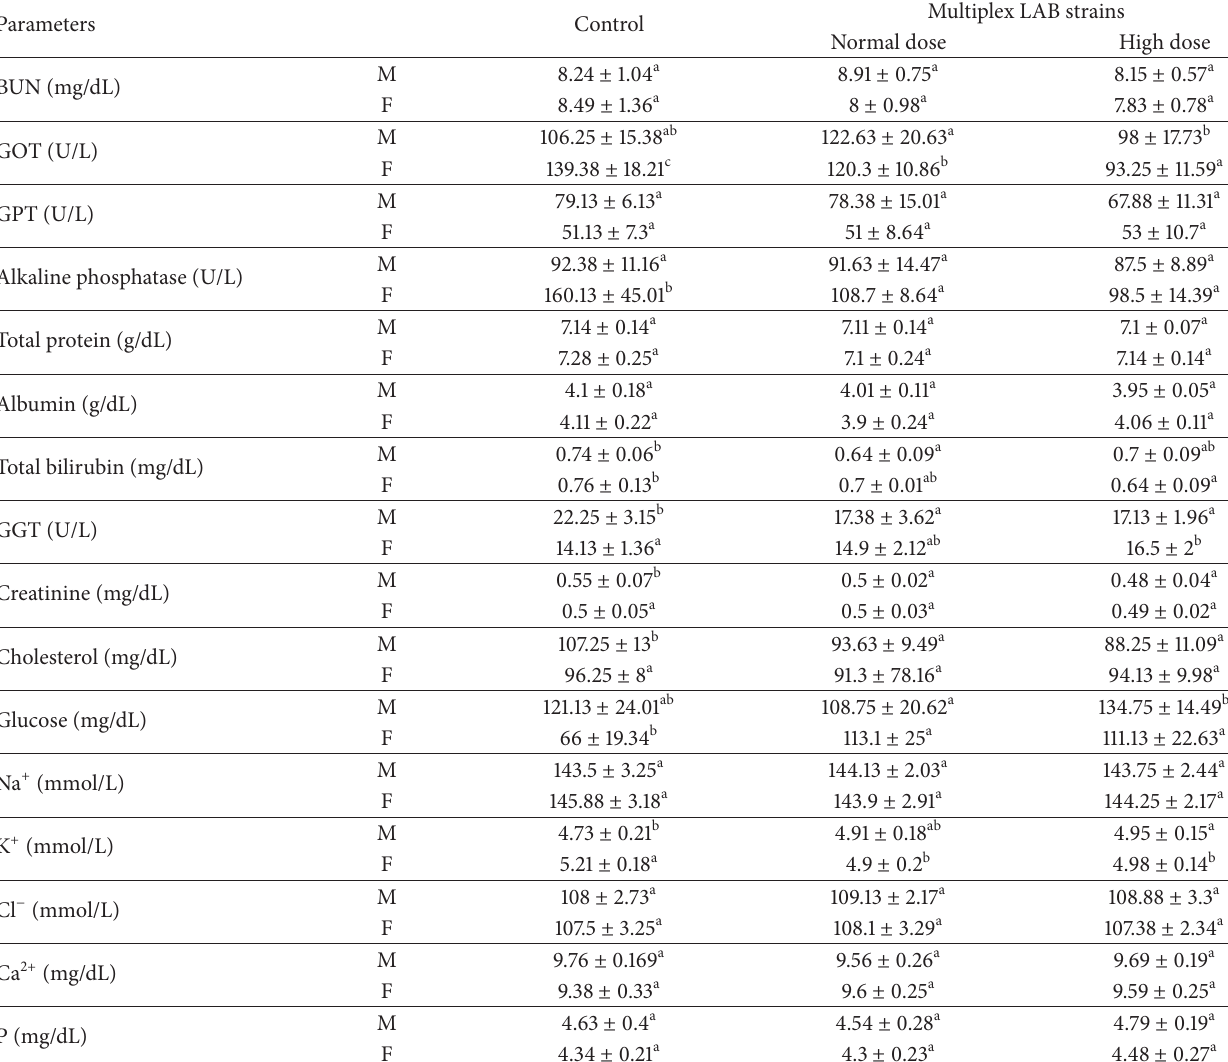
Table 3: Blood chemistry in rats that were treated orally with multiple LAB strains for 28 days.